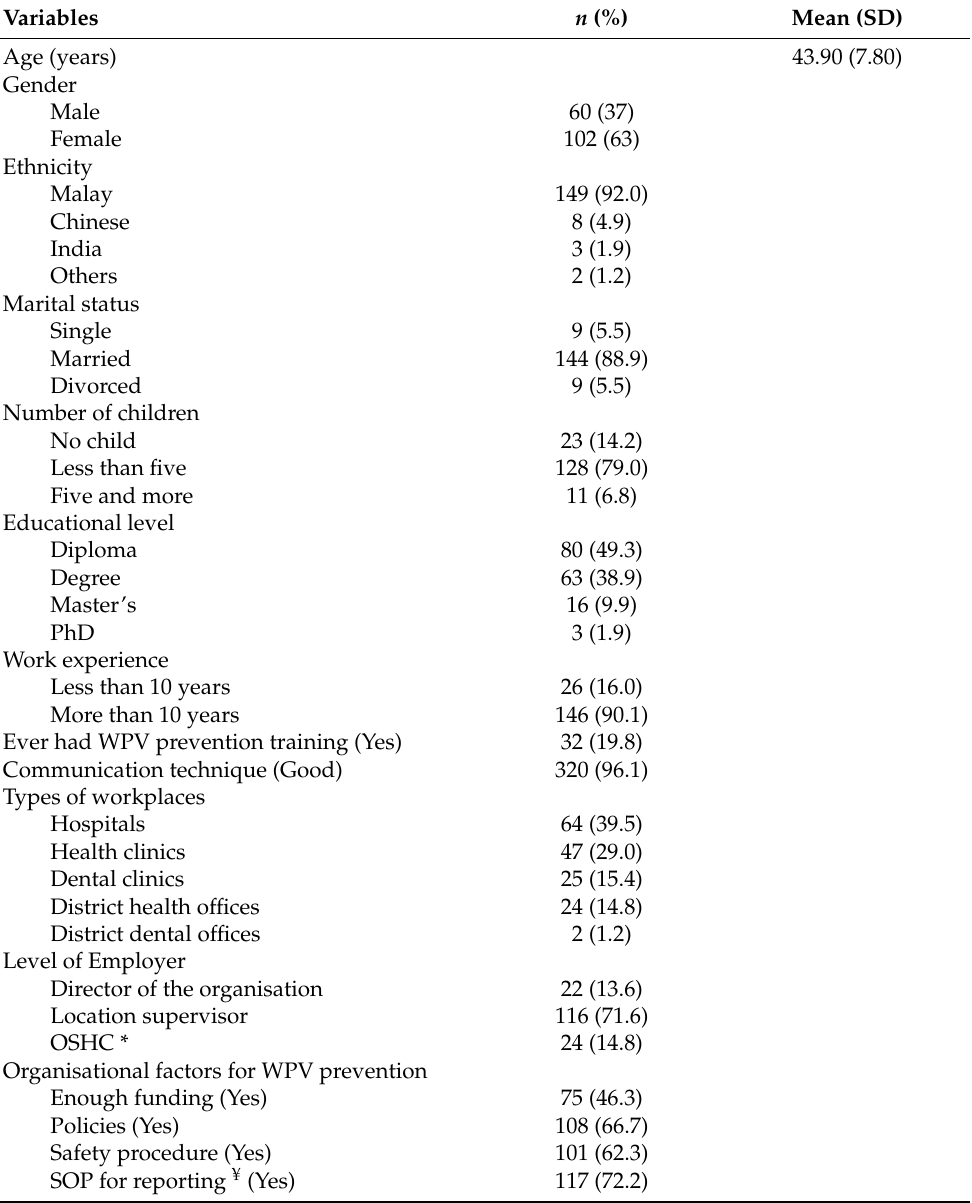
Table 1. Characteristics of employers at healthcare facilities in Melaka in a cross-sectional study ( n =